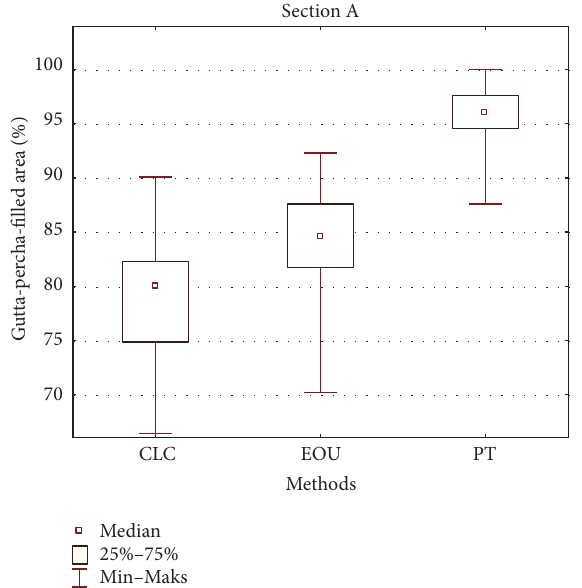
Figure 7: Box plots illustrating the median traces and minimal and maximal values of the gutta-percha-filled area in each experimental group, section A.